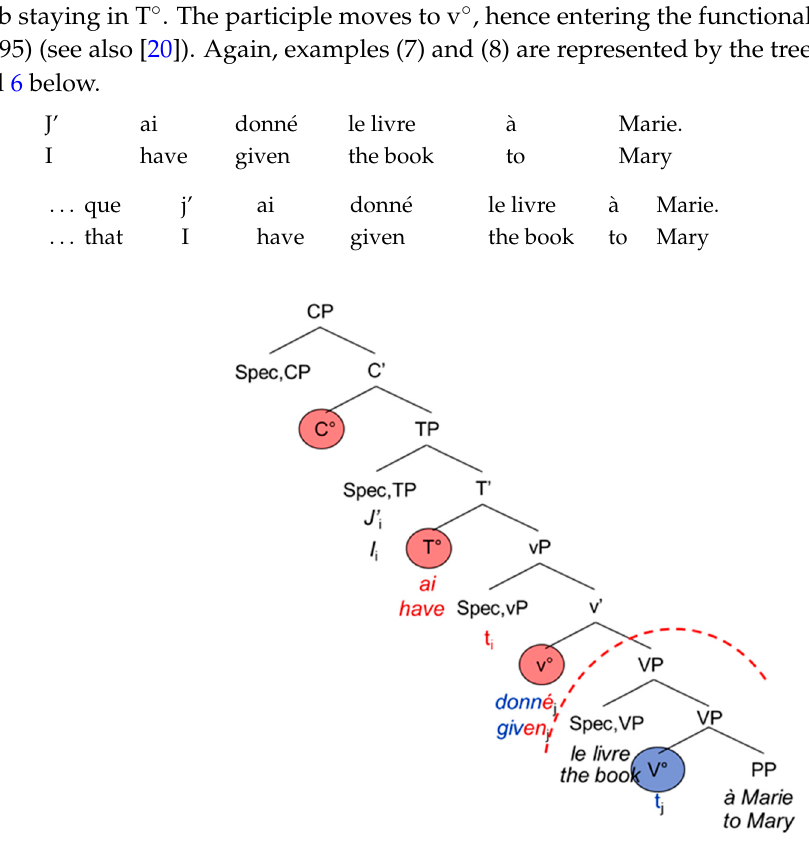
Figure 4. Structure of the German subordinate clause.